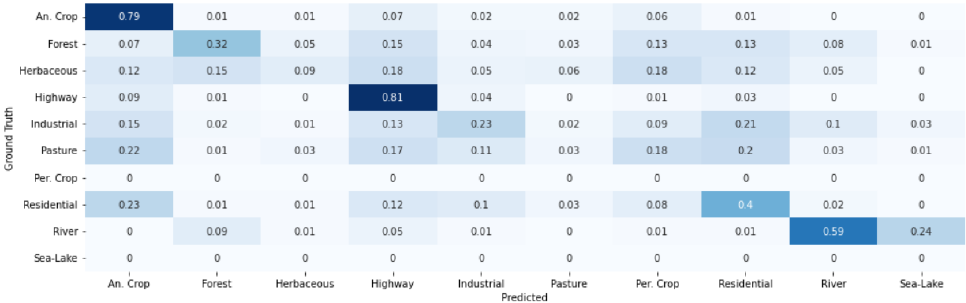
Figure 7. Performance of the segmentation